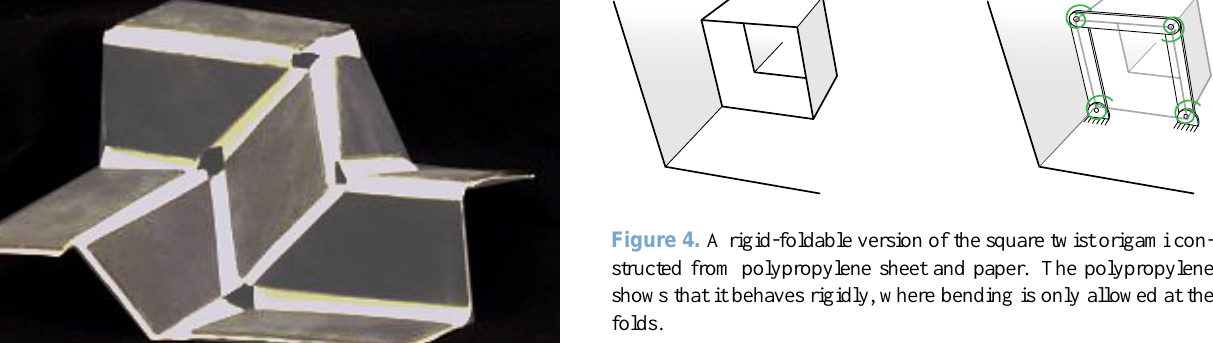
Fig. 4. A common double slit kirigami modeled and its correspond- ing PRBM.